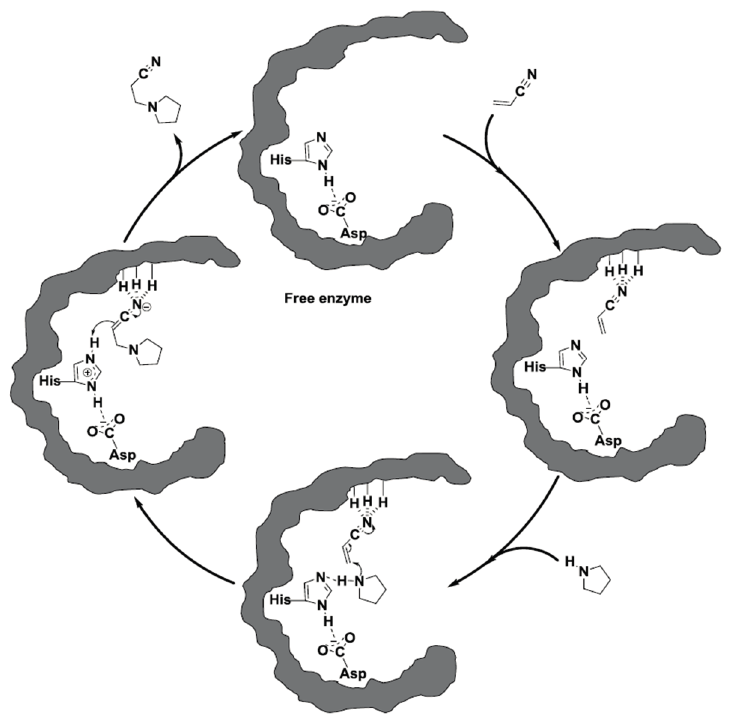
Figure 6. Suggested mechanism for the CALB-catalyzed Michael addition of pyrrolidine to acrylonitrile